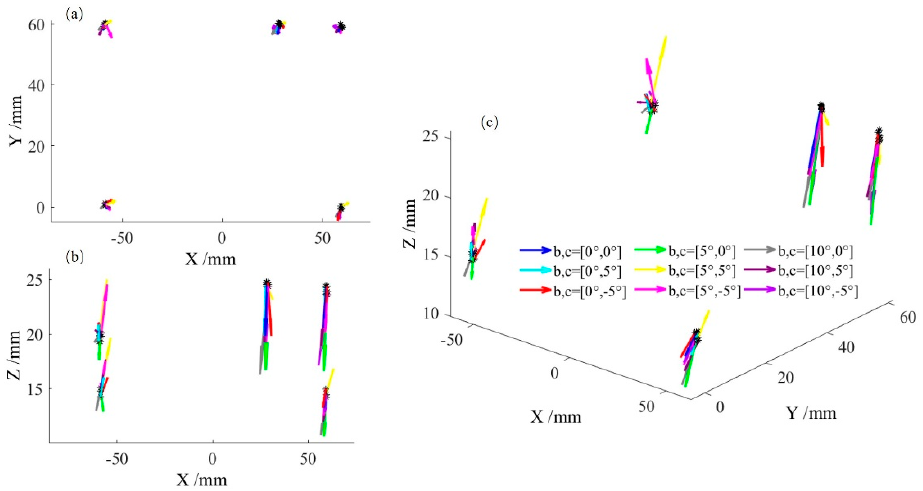
Figure 7. Distribution of the volumetric errors of the multi-axis machine tool occupied by the workpiece at nine locations by rotating the b and c axes: ( a ) xy view, ( b ) xz view, ( c ) 3D view, the errors are multiplied by 10,000.